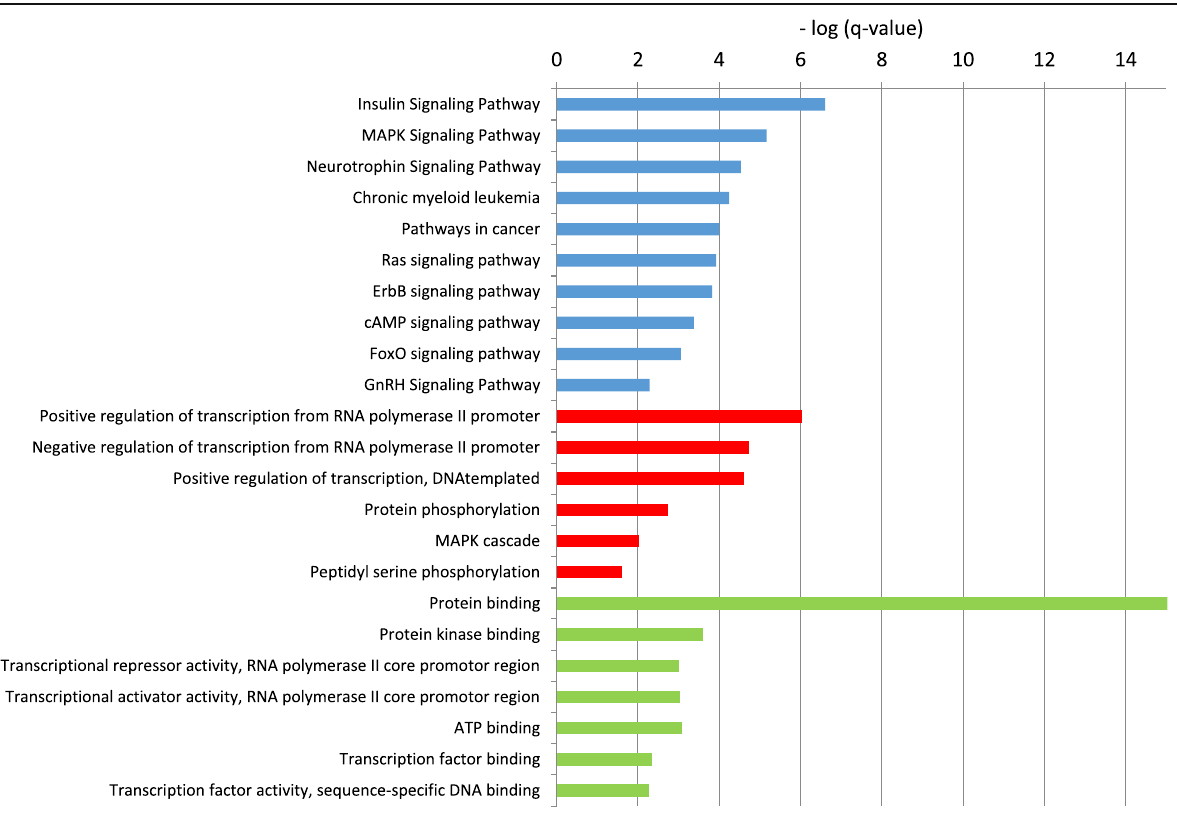
Fig. 3 The GO and KEGG pathway analyses of the upregulated microRNAs. Blue bars represent highly enriched KEGG pathways, while red and green bars represent highly enriched biological processes and molecular functions, respectively. q value: FDR adjusted p